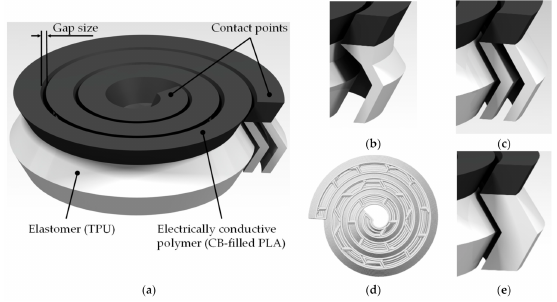
Figure 1. Render showing the sensor design ( a ). The black top is electrically conductive polymer, the white substructure is flexible elastomer to control the mechanical behavior of the sensor. Details ( b – e ) show substructure variants 1 to 4 respectively, each structure with increasing stiffness. For variant 3, the toolpath from the underside is depicted, as the CAD (computer-aided design) models for variants 3 and 4 are identical. The difference in stiffness is created through lower infill during printing for variant 3, whereas 4 is solid.